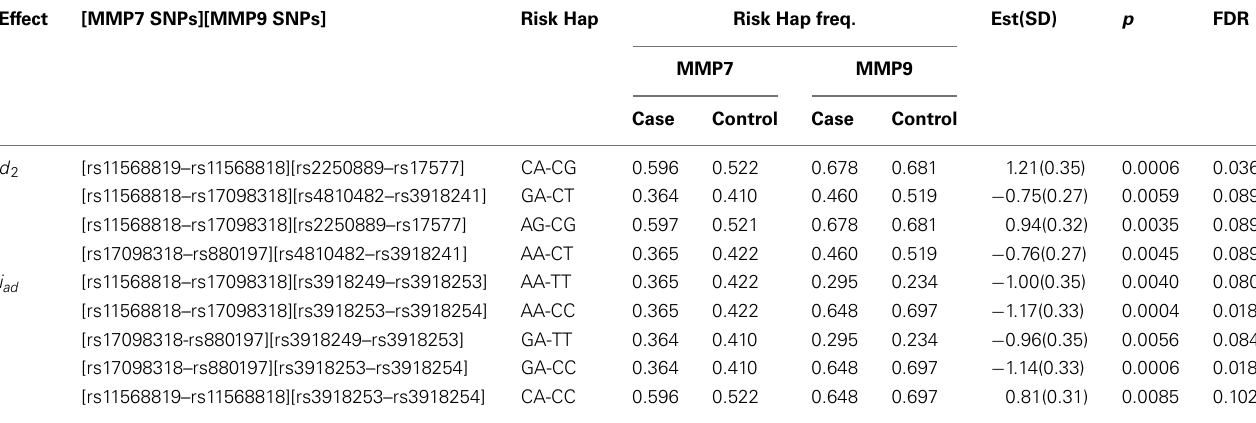
Table 5 | Estimation and significance test (corrected for multiple comparisons using FDR) of genetic effects on sarcoidosis risk by haplotypes composed of SNPs from MMP7 and